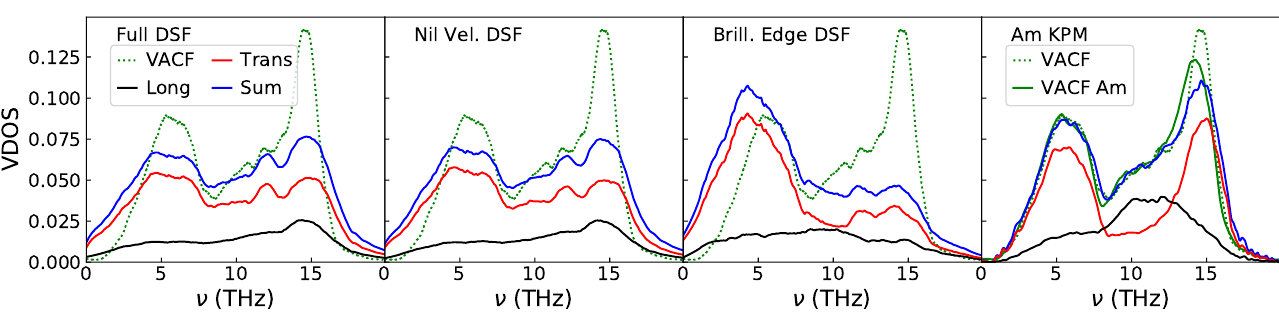
Figure A2. VDOS computed using different methods. The red and blue lines correspond, respectively, to the transverse and longitudinal polarizations. The solid blue and green dashed lines correspond to the total VDOS computed, respectively, via the DSF or the VACF. The first panel starting from the left uses the full DSF, the second the DSF limited to the theoretical wave-vector limit of the BZ of c-Si, the third the DSF limited to the wave vector giving a 0 velocity and the last the results using the KPM for an amorphous